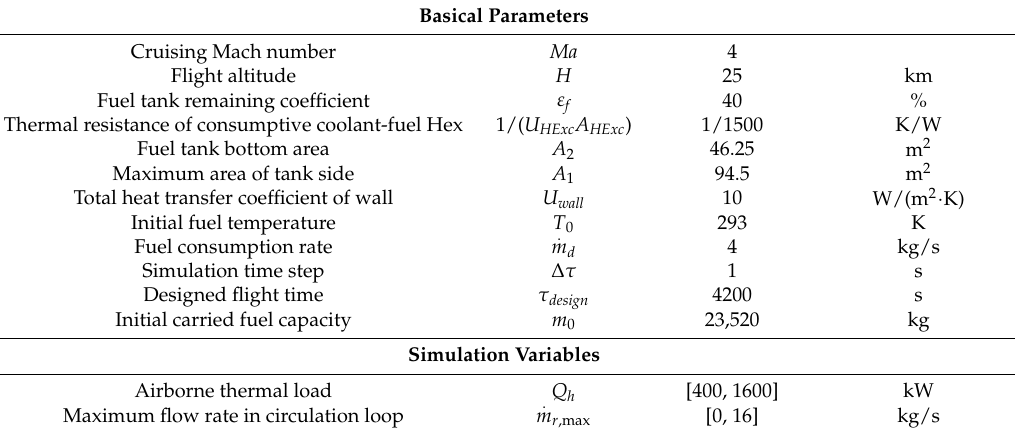
Table 2. Simulation